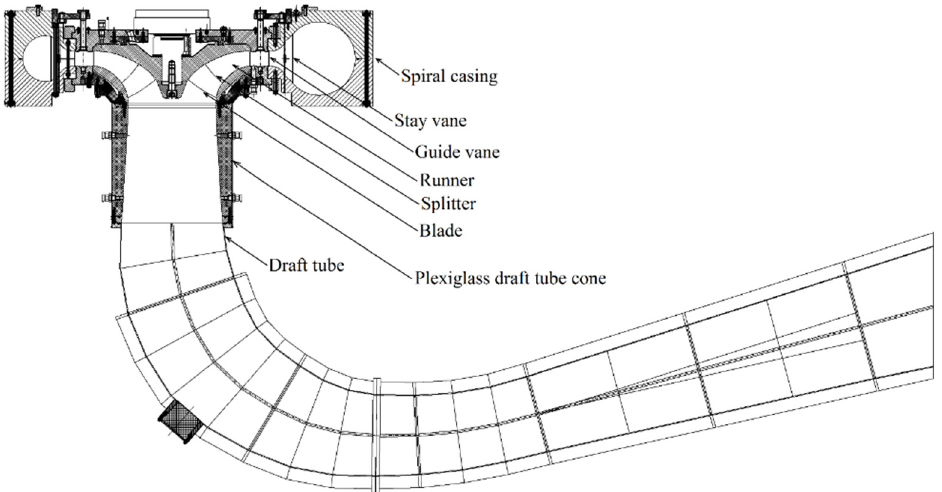
Figure 1. Two ‐ dimensional view of the investigated model Francis turbine. Figure 1. Two-dimensional view of the investigated model Francis